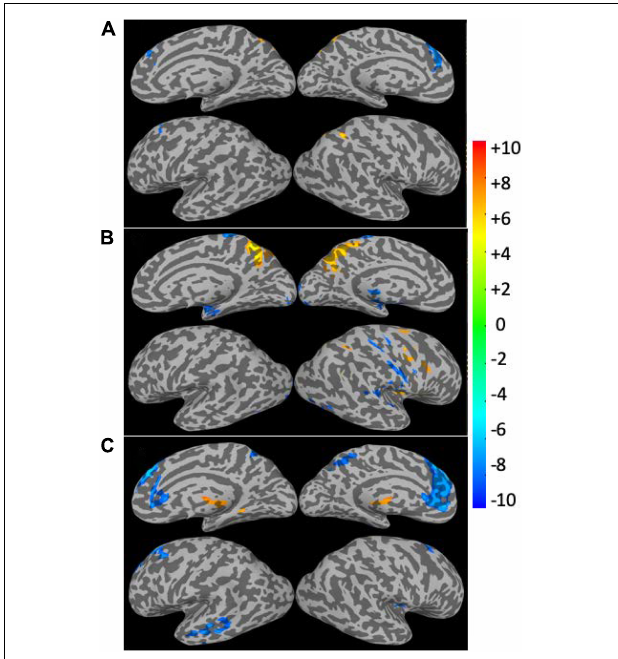
FIGURE 5 | Brain regions with significant correlation ( p < 0.05, corrected) between the connectivity strength metrics and the subject’s age. The results for the CSI (A) , CSI N (B) , and CSI P (C) are depicted separately. The Color bar shows the t -score